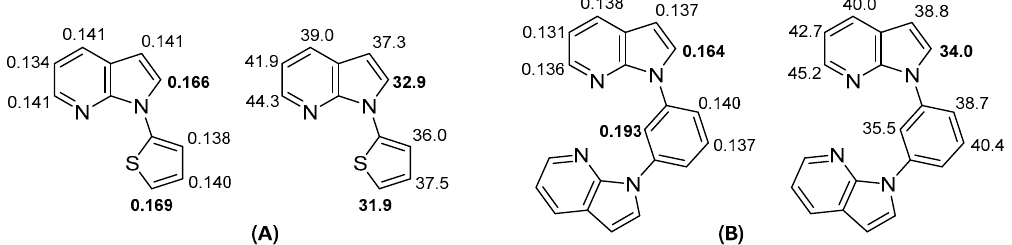
Figure 6. Calculated H charges and p K a values of 1-(2-thienyl)-7-azaindole ( 1g ; A ) and 1,1 ′ -(1,3-phenylene)bis(7-azaindole) ( 2k ; B ).